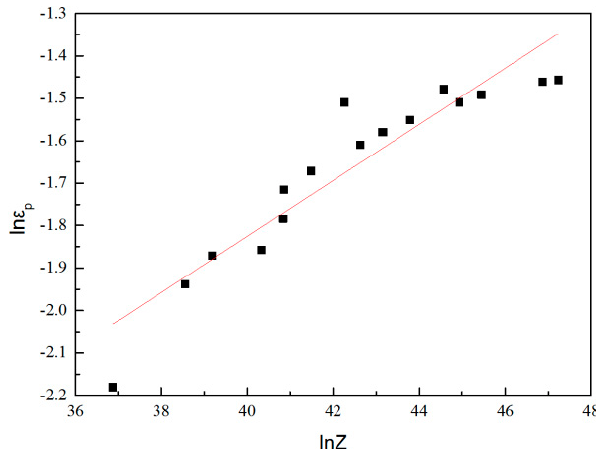
Figure 8. The relation between lnZ and ln ε p at various deformation temperatures.